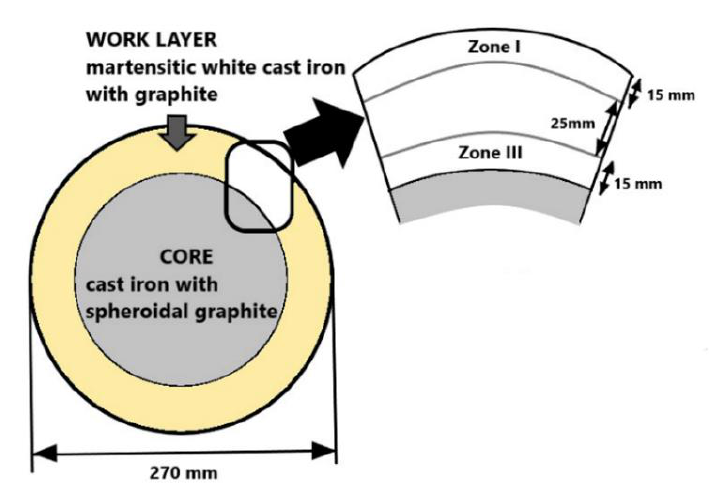
Figure 2. Analysis zones in the work layer.